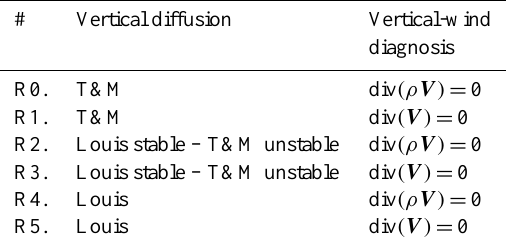
Table 4. Description of the 6 reference models.